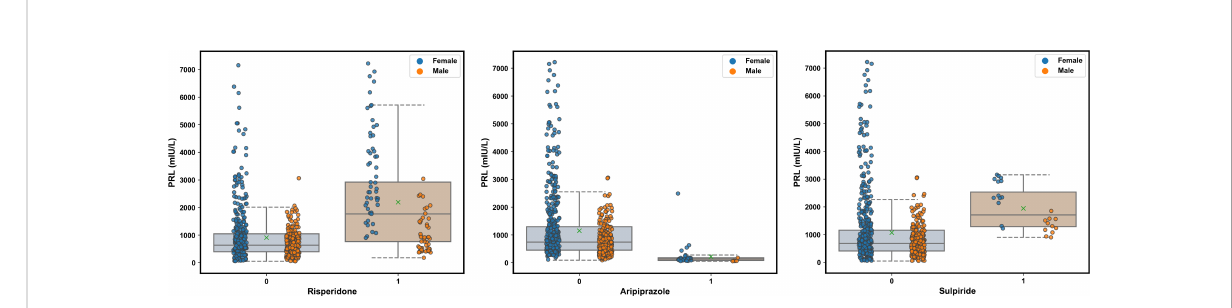
FIGURE 5 Comparisons of the in fl uence of the co-administered risperidone, aripiprazole, and sulpiride on the PRL levels in terms of the gender of patients taking olanzapine (OLZ) according to the original data. The green multiplication sign indicates the mean PRL